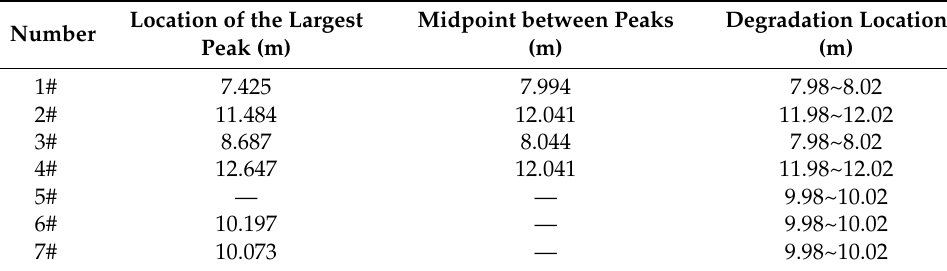
Table 3. The locating results of 1#–7# cables.